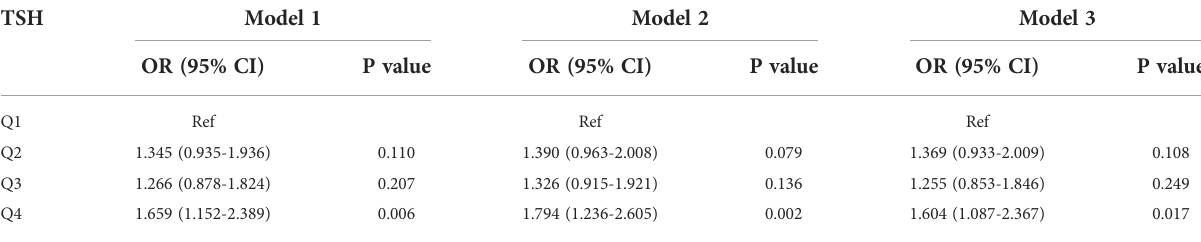
TABLE 2 Association of thyroid stimulating hormone level with Helicobacter pylori seropositivity. TSH Model